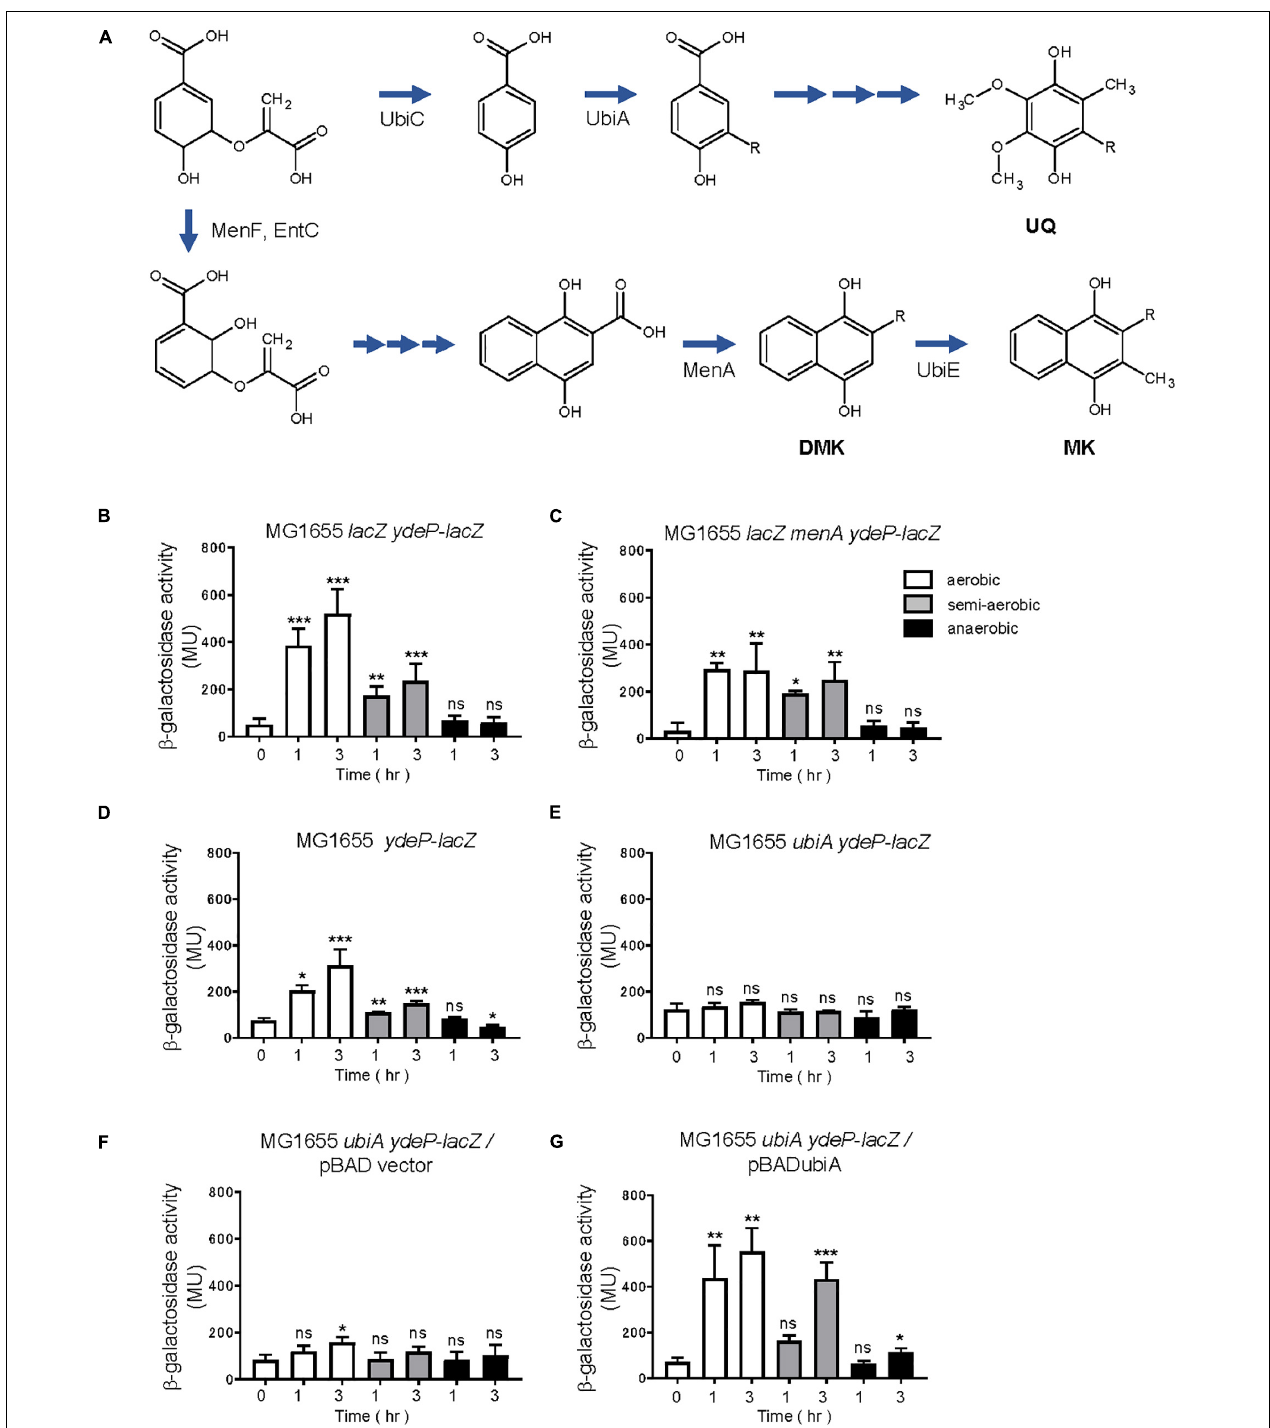
FIGURE 8 | Ubiquinone is required for EvgS/EvgA activation. (A) Biosynthesis of ubiquinone (UQ), demethylmenaquinone (DMK), and menaquinone (MK) in E. coli (arranged from reference, van Beilen and Hellingwerf, 2016). (B–G) Activity of the ydeP-lacZ reporter in different culturing conditions (upper panels). Cells were grown in EvgS-activation medium with 0.02% arabinose under aerobic (white bars), semi-aerobic (gray bars), or anaerobic condition (black bars) at 37 ◦ C. Uracil was added to the medium at a concentration of 1 mM for experiments (D–G) . Optical density at 600 nm of the cell cultures subjected to reporter assays is shown in Supplementary Figure 13 . Data represent the average of three biologically independent replicates. Error bars indicate the standard deviation, and statistical analyses of each redox condition group were performed as described in Figure 1 . ns, not significant; *0.01 ≤ p < 0.05; **0.001 ≤ p < 0.01; *** p < 0.001. (B) MG1655 lacZ ydeP-lacZ , (C) MG1655 lacZ menA ydeP-lacZ (no DMK/MK), (D) MG1655 ydeP-lacZ , (E) MG1655 ubiA ydeP-lacZ (no UQ), (F) MG1655 ubiA ydeP-lacZ/ pBAD vector (no UQ), (G) MG1655 ubiA ydeP-lacZ/ pBADubiA (with UQ).